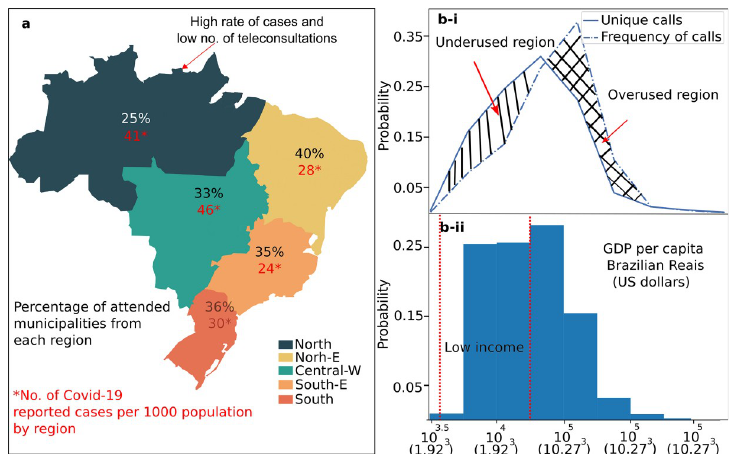
Fig 2. The proportion of municipalities attended by TRS in Brazil by region. (a) The Northern region has a high rate of confirmed cases (41) but a low number of teleconsultations (25%). (b) The percentage of attended municipalities according to its GDP per capita. The straight line represents the frequency of calls by GDP (unique calls), while the dashed line is the frequency of municipalities taking all calls into consideration. High-income municipalities perform more COVID-19 teleconsultations than low-income municipalities, the differences denote overused and sub used regions.